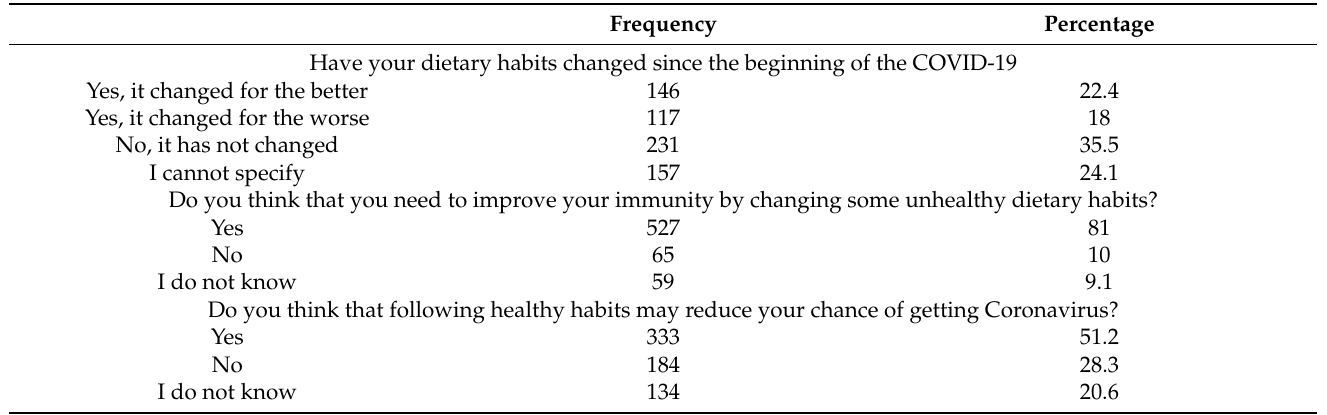
Table 5. Frequency and percentage distribution of behavior during the pandemic.